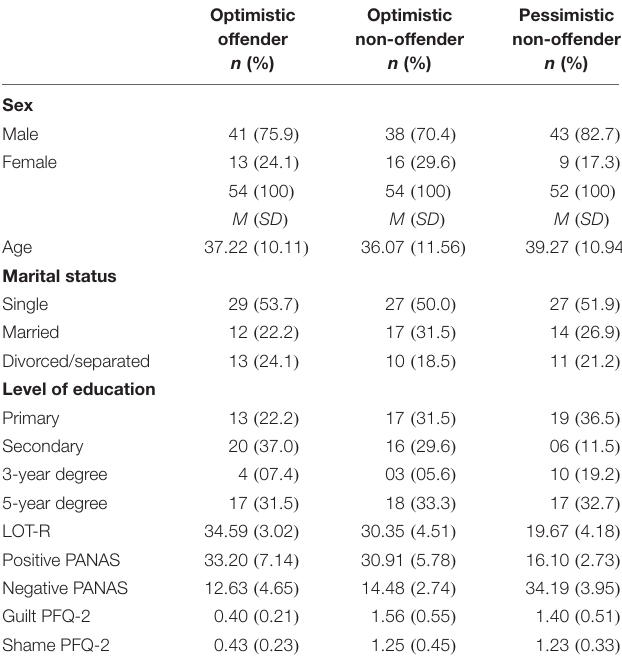
TABLE 1 | Statistics of demographic characteristics and measures between Study